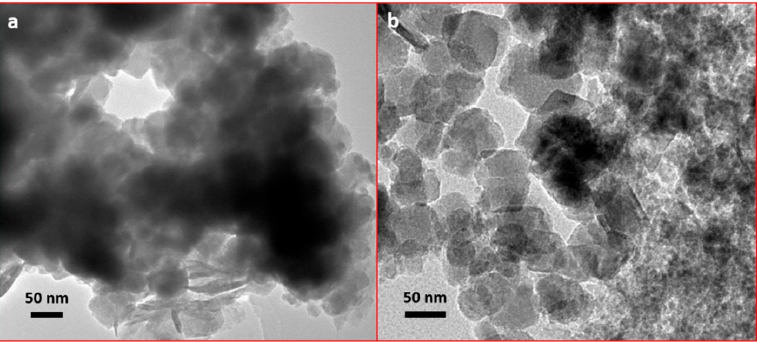
Figure 7. TEM images of ( a ) MFN loaded with excess Fe 3 O 4 particles (MoS 2 :Fe 3 O 4 , weight ratio of 5:2), ( b ) MFNNs with excess free nZVI particles (MoS 2 :Fe 3 O 4 :nZVI, weight ratio of 4:1:1.15).